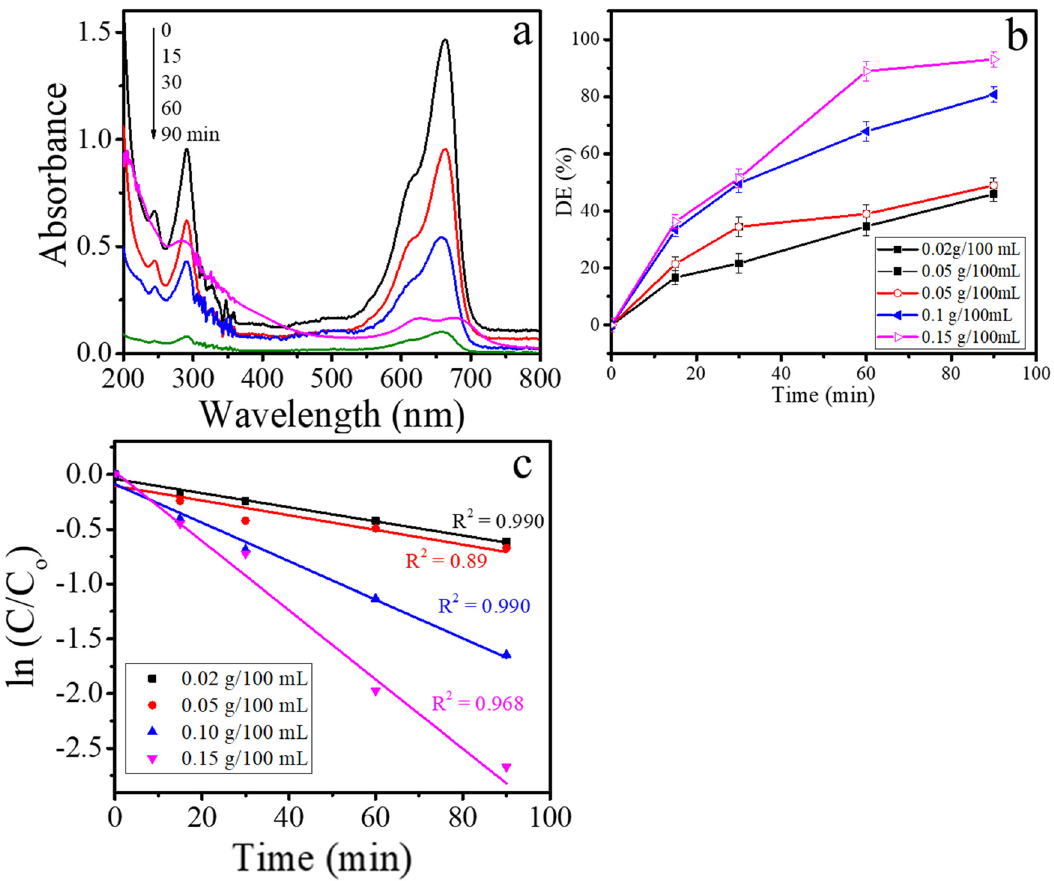
Figure 7: ( a ) Spectral change of MB by photocatalytic degradation, ( b ) kinetics plot of MB removal and ( c ) pseudo - fi rst order plot of MB